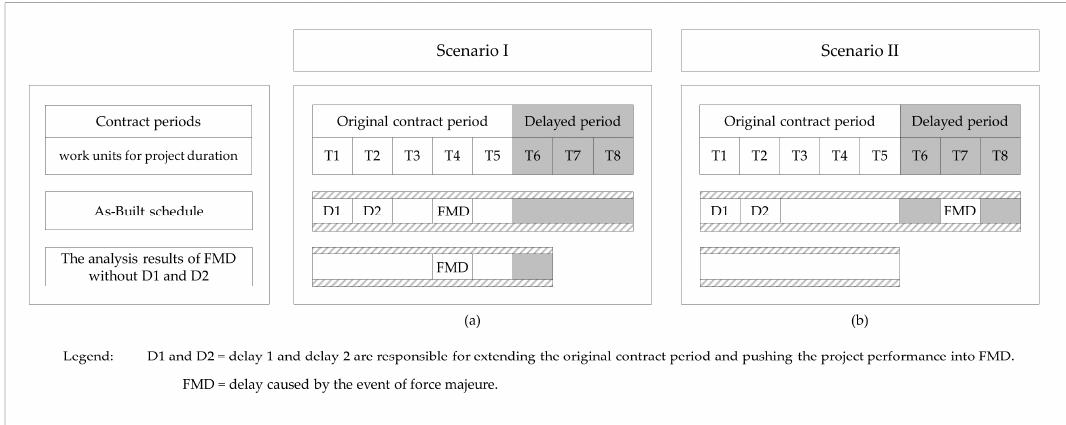
Figure 1. The two timings for the occurrence of force majeure delay during the contractual periods.